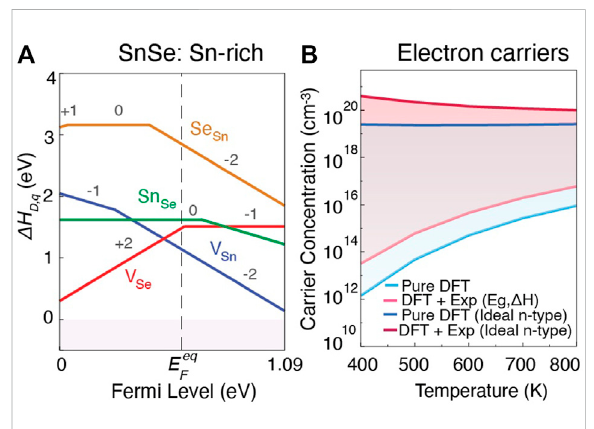
FIGURE 8 (A) DefectformationenergiesasafunctionofFermilevel,and (B) intrinsic and ideal carrier concentrations for electrons under Sn-rich growth conditions in SnSe ( Pnma ). The lighter and darker shades in (B) indicate electron carrier concentrations for undoped and ideal extrinsically doped materials,